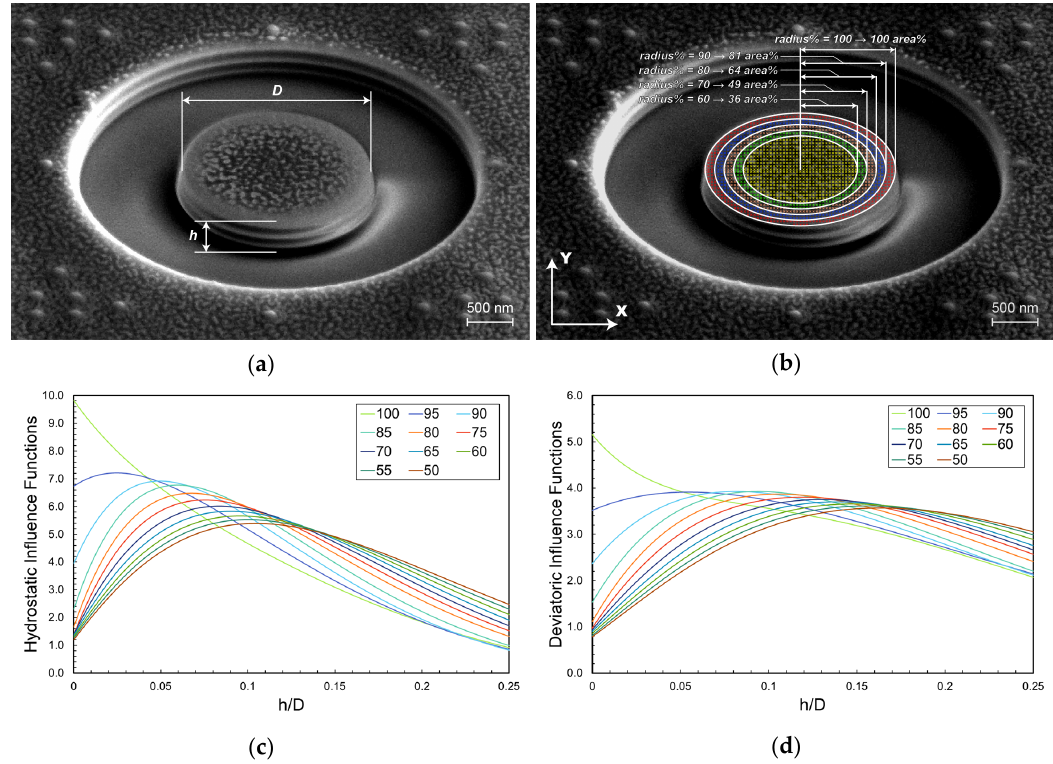
Figure 2. ( a ) Experimental example of ring-core focused ion beam (FIB) milling, ( b ) the idea of multiple area% digital image correlation (DIC) analysis for improving depth resolution and surface sensitivity, ( c ) FEM calculated hydrostatic part of the kernel function F(z/D) for several values of the radius% , ( d ) deviatoric components of the kernel functions for several values of the radius% (which defines the corresponding area% for DIC analysis, as reported in Figure 2a,b).